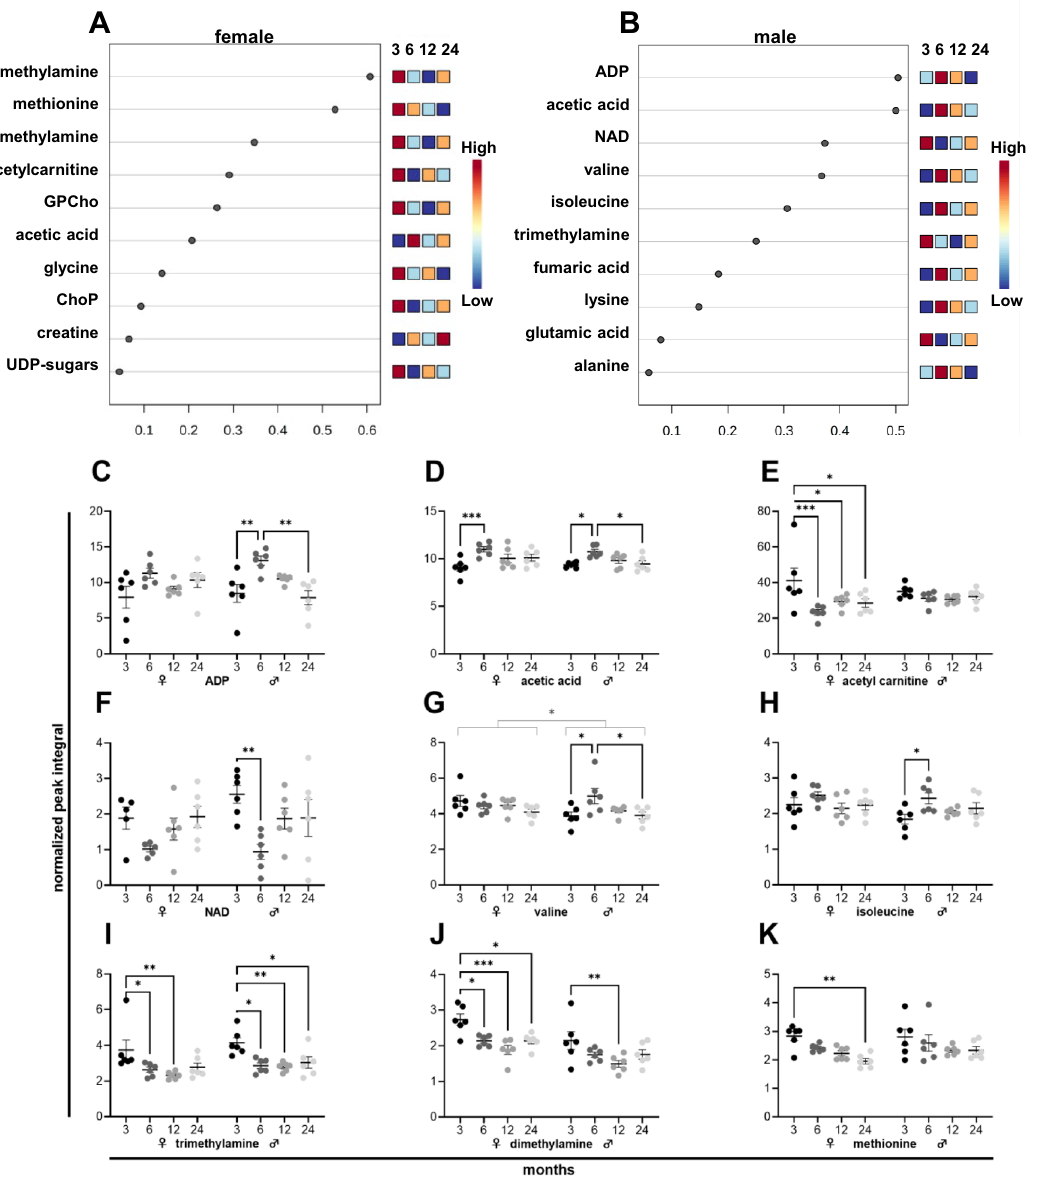
Figure 5. NMR metabolomics of female and male murine heart samples. Metabolites of six female ( A ) and six male ( B ) mice ranked based on the variable importance during projection (VIP) score as a function of age. Individual metabolite levels of female (left) and male (right) tissues at 3, 6, 12, and 24 months presented as normalized peak integral ( C – K ). ADP Adenosine diphosphate, ChoP Phosphorylcholine, GPCho Glycerophosphocholine, NAD Nicotinamide adenine